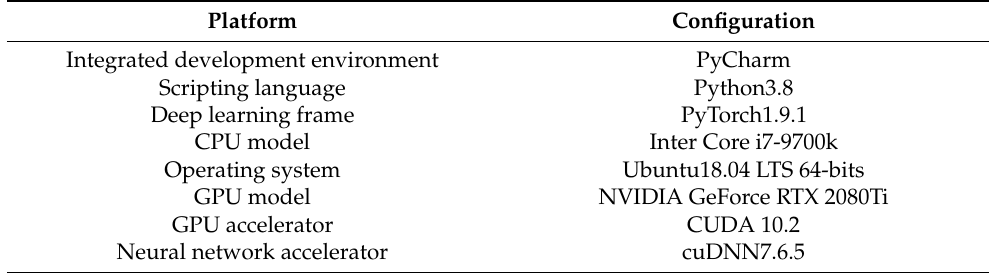
Table 2. Software and hardware configuration of the experimental environment.